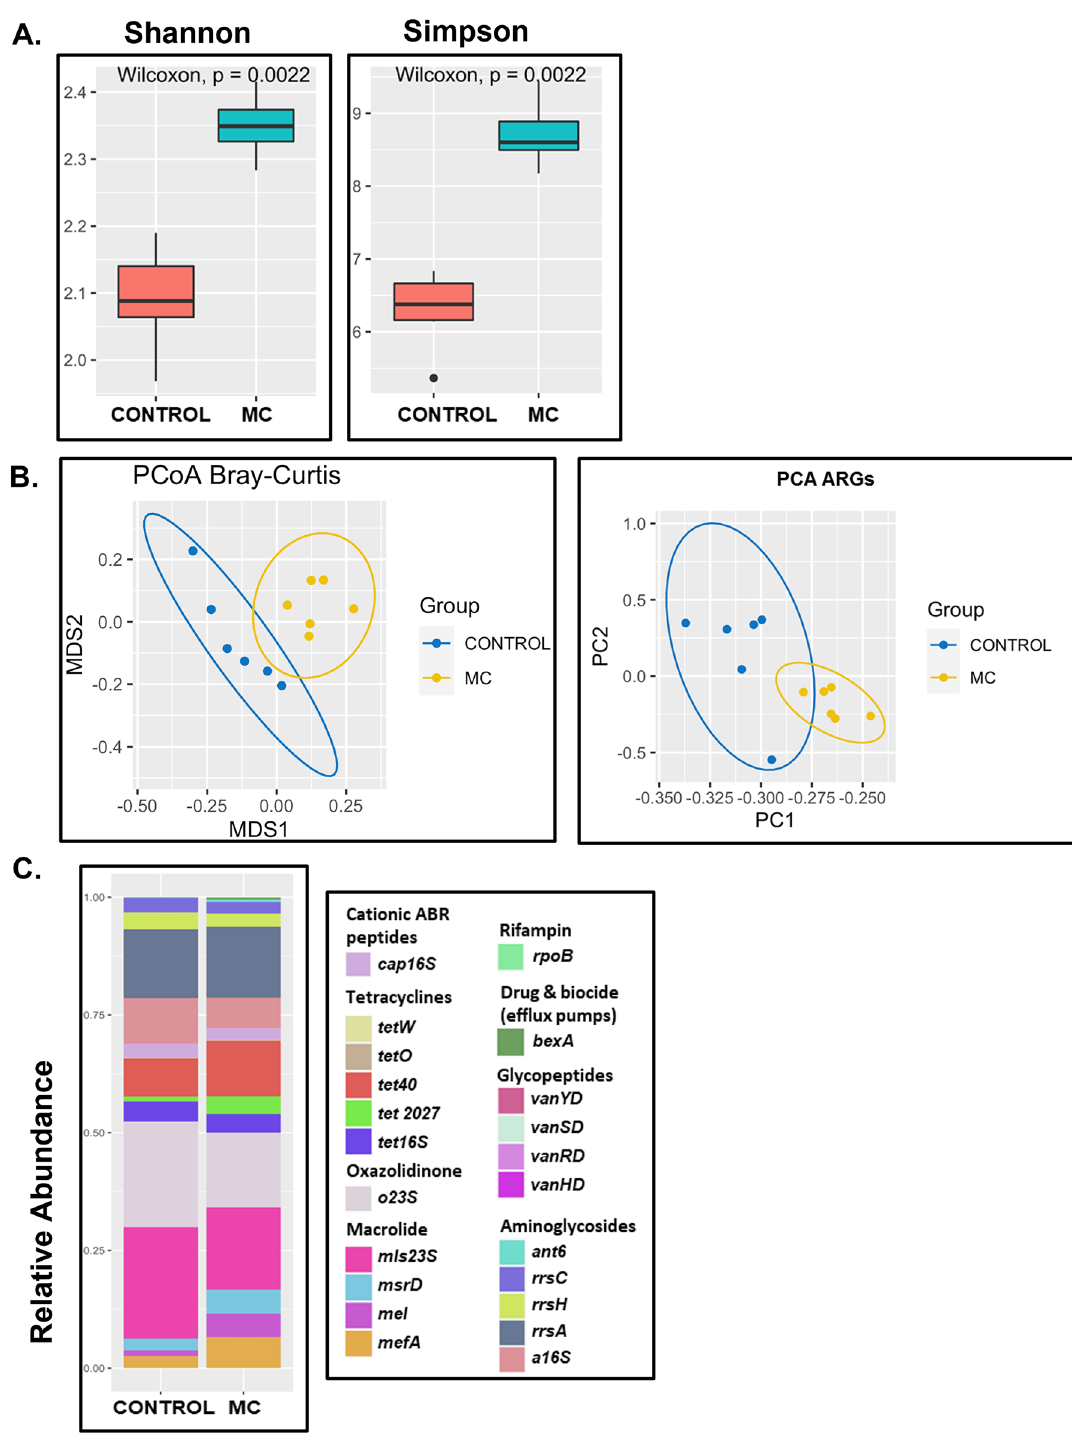
Figure 3. Diversity of Resistome. MC-treated samples showed ( A ) higher α-diversity (Shannon index and Simpson index) of ARGs and ( B ) distinct β-diversity (Bray–Curtis) marked by PCoA plot and similar separation pattern of ARGs represented by PCA plot in their resistome. ( C ) Resistance gene abundance profile for CONTROL and MC